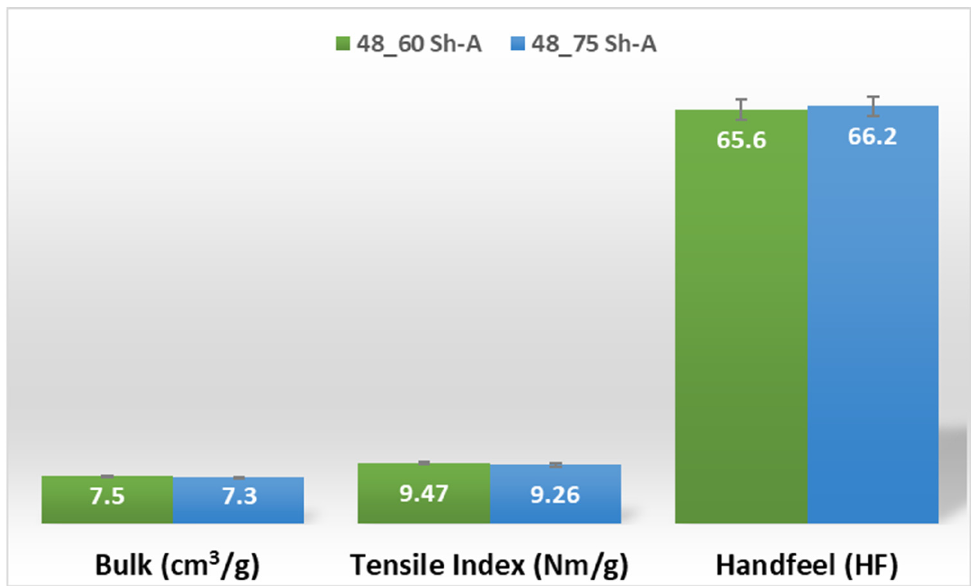
Figure 14. Bulk, tensile index, and handfeel results for deco embossing and configuration 3 rubber hardness conjugation.